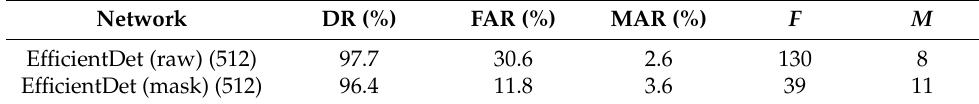
Table 1. Comparison of airport detection algorithms effectiveness of EfficientDet network.